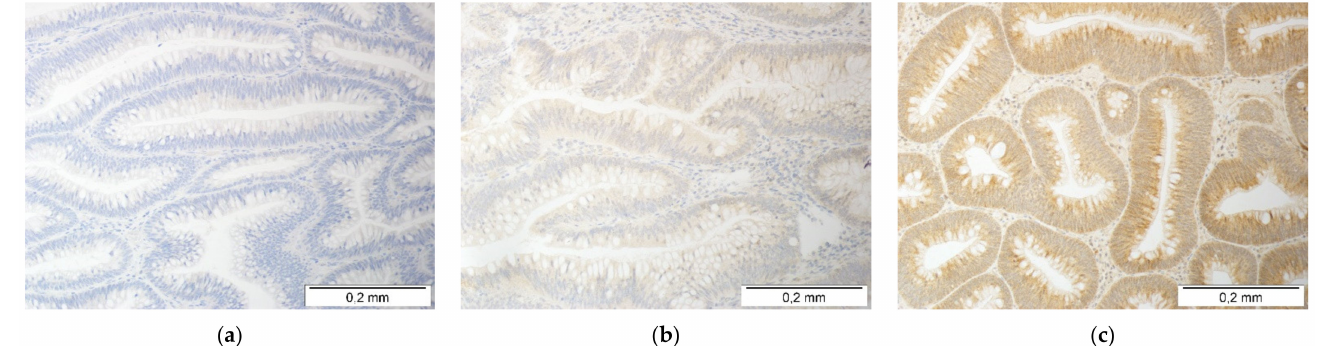
Figure 1. Immunohistochemical analysis of MCP-1/ CCL2 protein expression in colorectal adenomas: ( a ) negative reaction, with no reaction in the glandular epithelial cells or it only occurring in the stromal area of the lesion; ( b ) a weak cytoplasmic reaction, or the reaction did not encompass the entire lesion (score 1; +); and ( c ) a strong cytoplasmic reaction encompassing the entire lesion (score 2; ++). The tissue slides were incubated with rabbit anti-human MCP-1/ CCL2 antibodies with a DAB chromogen, stained brown in the case of a positive reaction and counterstained with hematoxylin. All the photos were taken at 200 × .